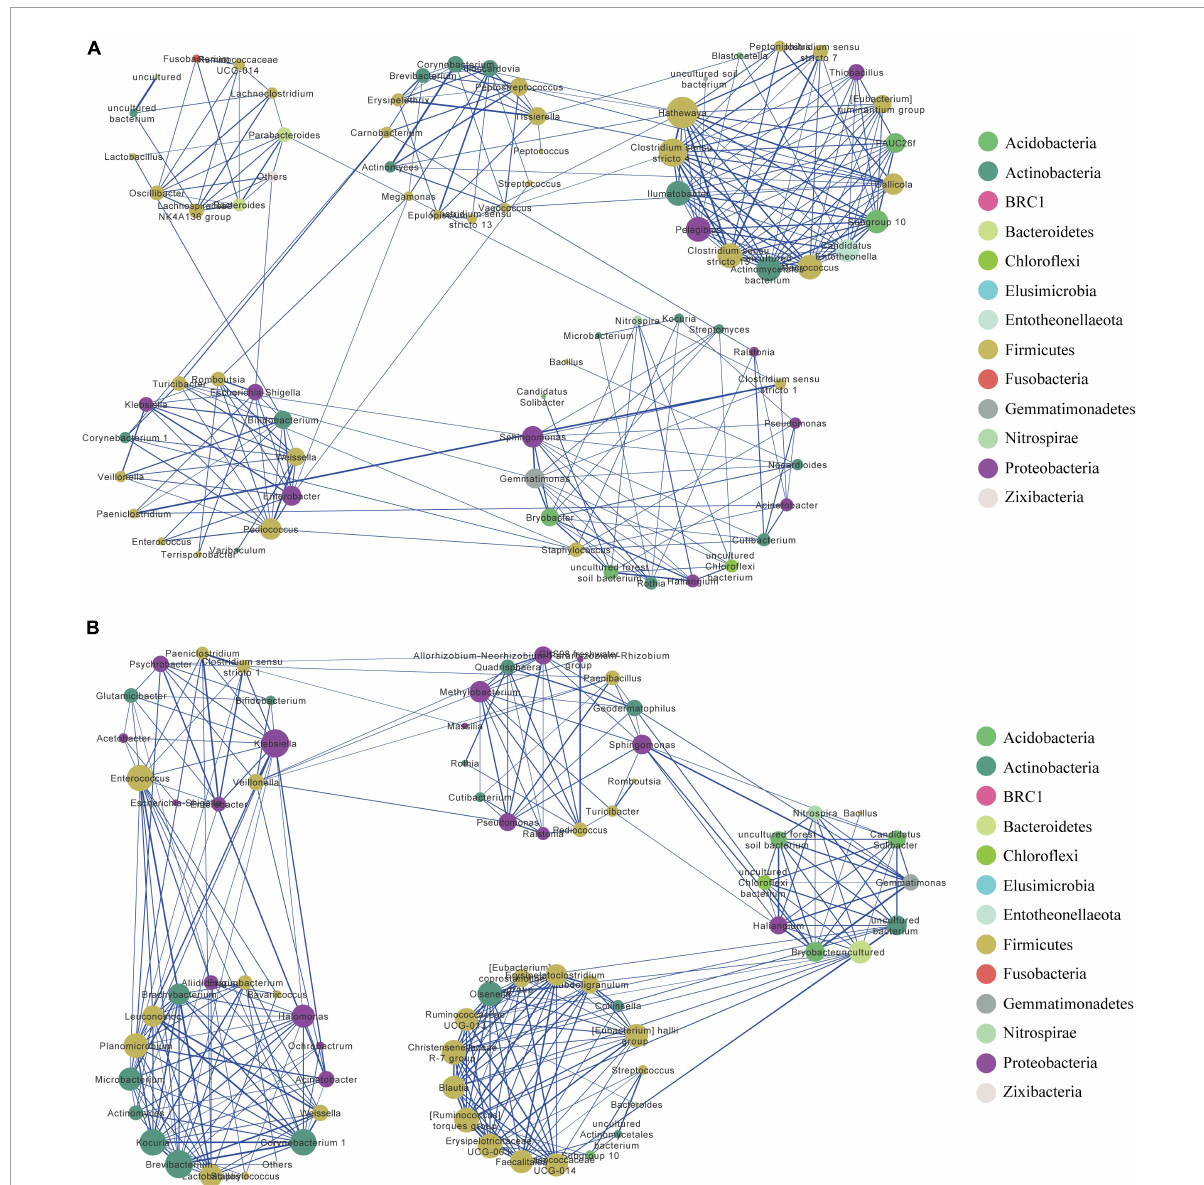
FIGURE3 Bacterial co-occurrence network in MQ (A) and YQ (B) based on positive correlation analysis at the genus level. Nodes correspond to genus and edges to the correlation. Node size is proportional to the degree number. Node color represents the associated phylum for each genus. Edge width displays the strength of correlation. The blue edge indicates a positive correlation. Each large circle (e.g., MQ-M1 or YQ-M1) represents a module detected by Louvain method. MQ, raptors; SQ, waders; YQ,